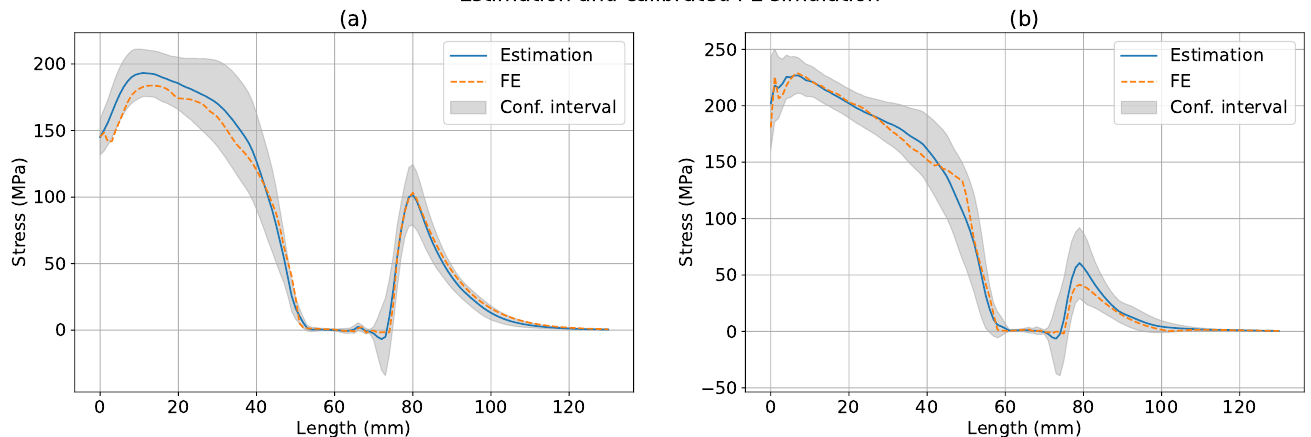
Figure 9. Maximum principal stress estimations obtained from noisy synthetic data, FE simulation and confidence interval. ( a ) Camera side. ( b ) Torch